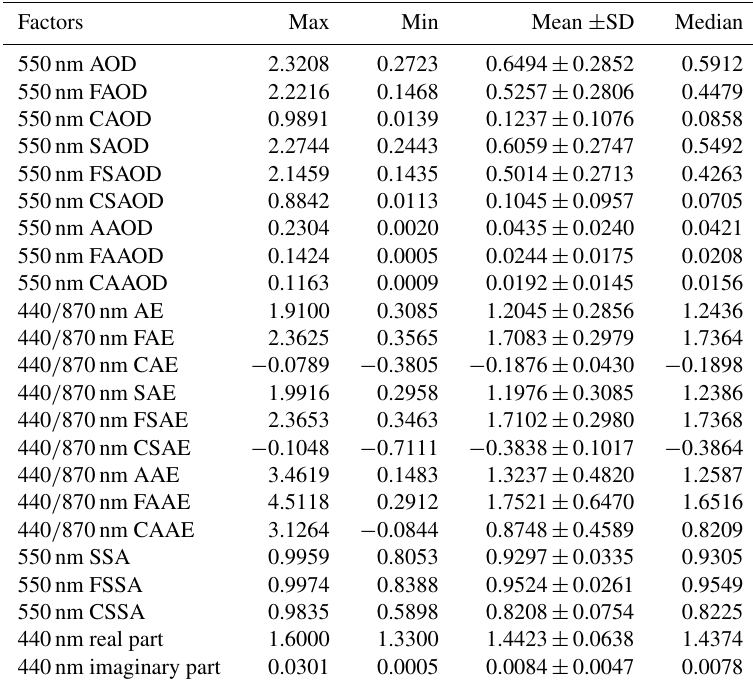
Table 1. Statistical summary of the columnar aerosol optical properties in the urban area of Nanjing. Factors Max Min Mean ±